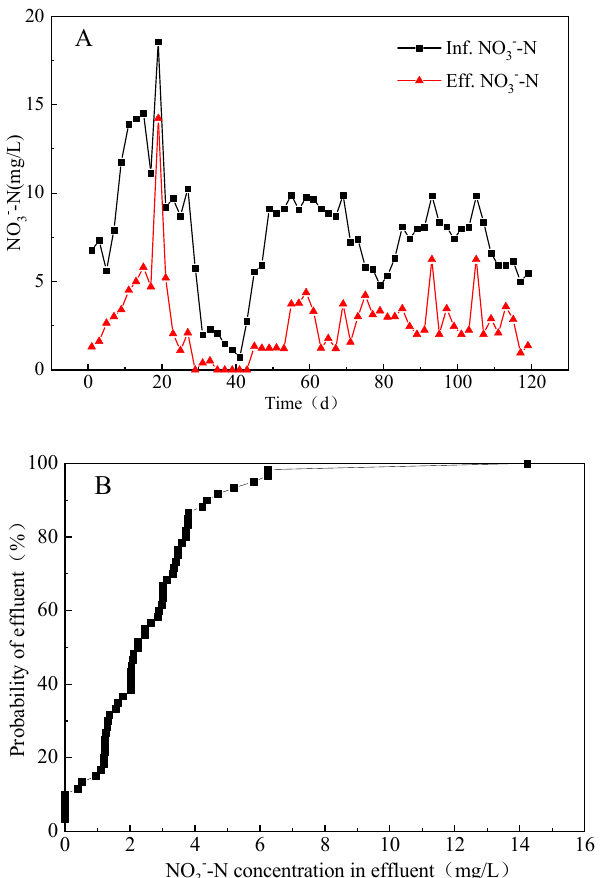
Figure 9. Nitrate removal ( A ) and effluent cumulative distribution ( B ) in the pilot-scale bioreactor.